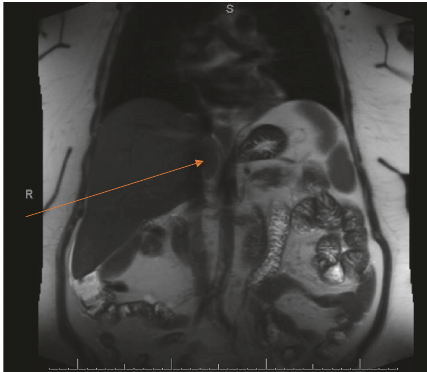
Figure 5: Presence of IVC thrombus at the infrahepatic level after neoadjuvant